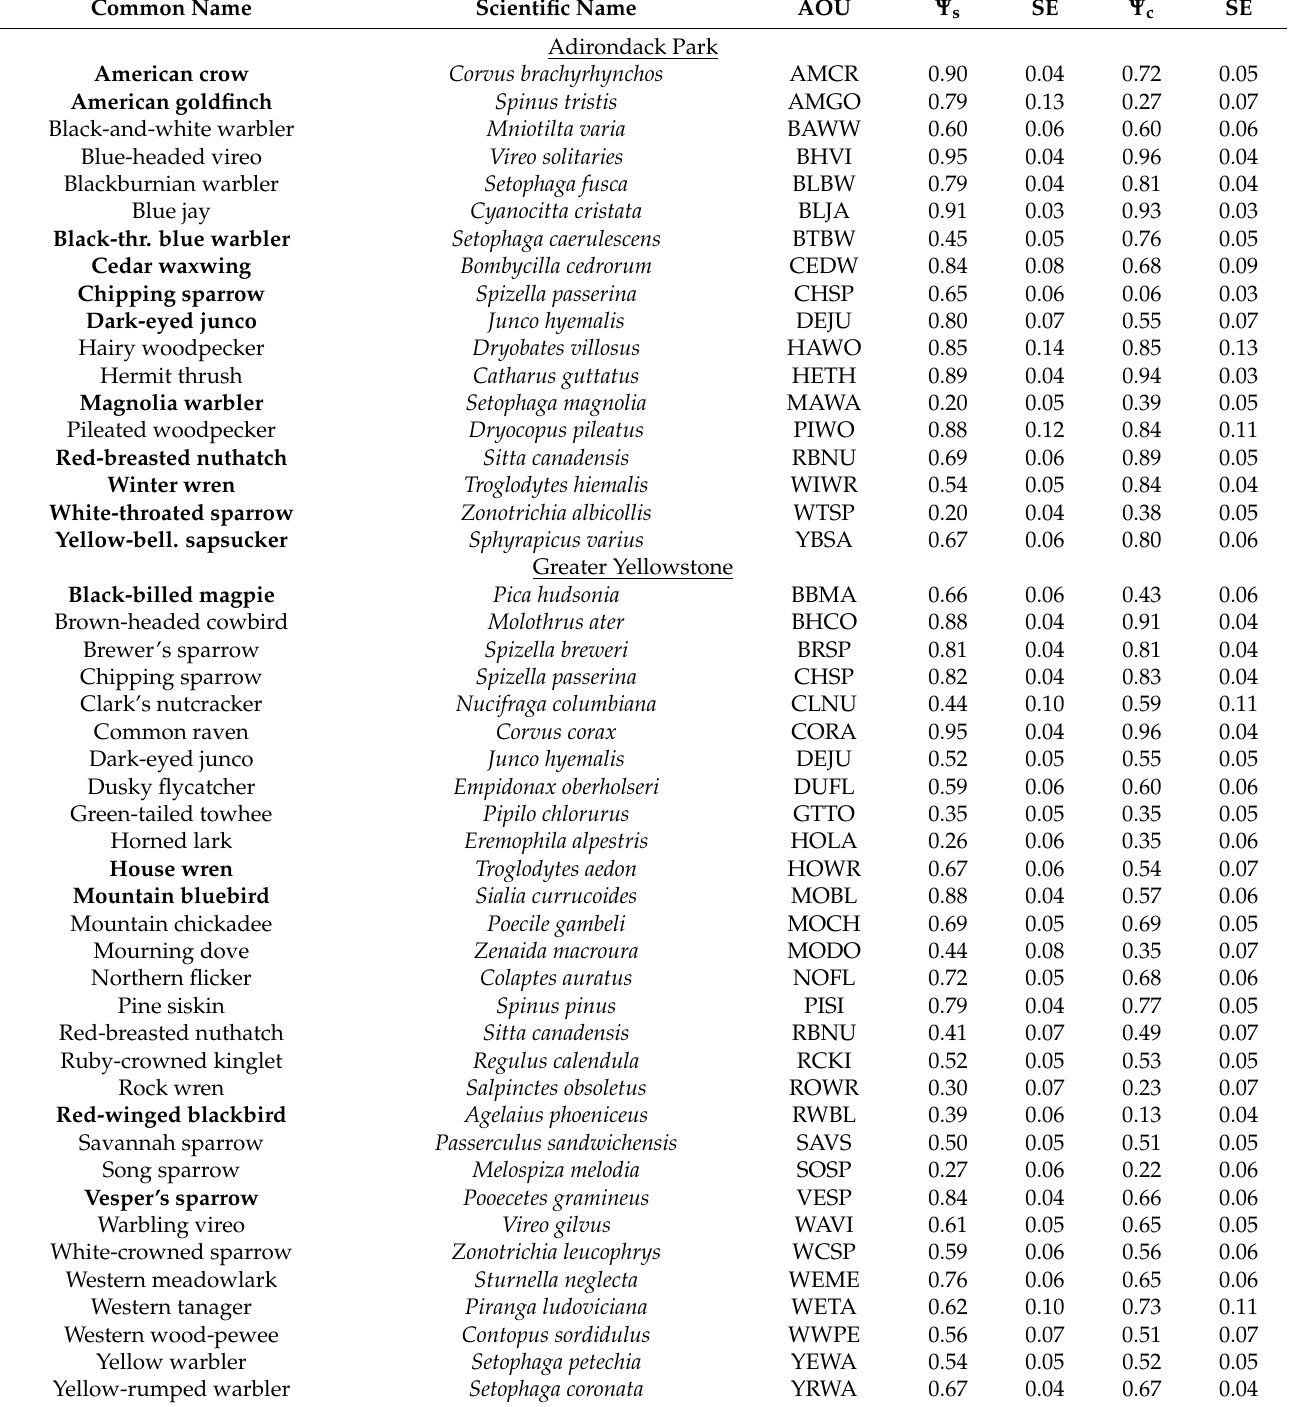
Table 3. Estimated use probabilities for individual bird species of subdivisions ( Ψ s ) and control sites ( Ψ c ) in Essex County, NY (Adirondack Park), and Madison County, MT (Greater Yellowstone) and associated standard errors (SE). Bold text denotes species for which model selection indicated support for a subdivision treatment effect ( ∆ AIC ≤ 2). AOU denotes American Ornithologists’ Union four-letter codes